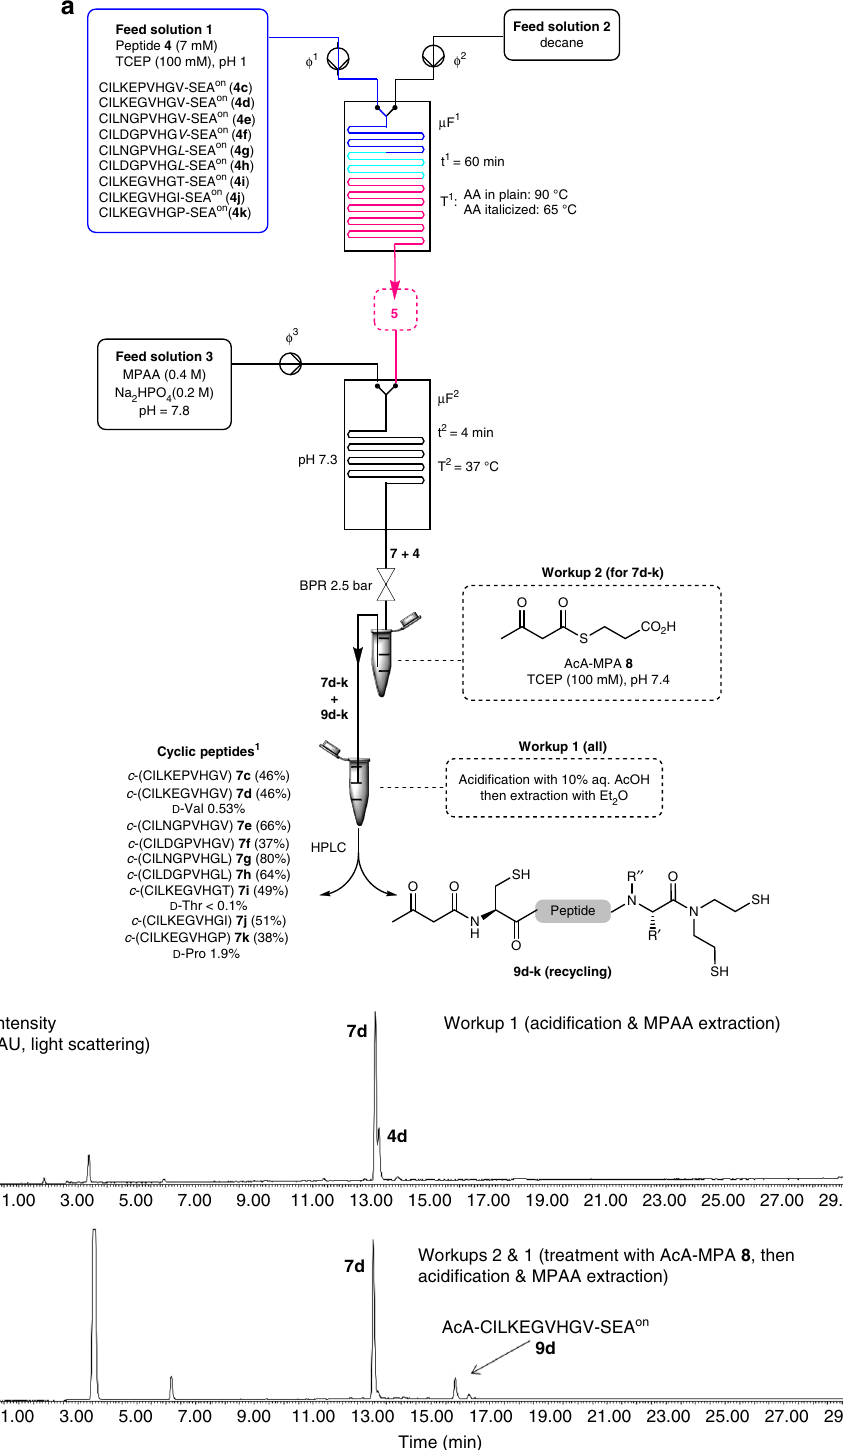
Fig. 4 Optimized micro fl uidic setup. a Details of the optimized micro fl uidic system. The pH of the MPAA feed solution was set at 7.80, leading to an optimum internal pH of 7.3 within micro fl uidic element µ F 2 , and the residence time t 2 to 4 min. ϕ 1 = ϕ 2 = 3.3 µ L min − 1 , ϕ 3 = 35 µ L min − 1 . The back pressure regulator (BPR) was set at 2.5 bars. The peptide concentration in the Feed solution 1 was 7 mM. For 7c , the reactor ef fl uent was quenched in 10% aqueous acetic acid. MPAA was then extracted with diethylether (5×) before HPLC analysis and puri fi cation (workup 1). For 7d-k , the cyclic peptide co-eluted by HPLC with the starting SEA on peptide 4 . Therefore, the reactor ef fl uent was treated fi rst with AcA-MPA 8 /TCEP dissolved in pH 7.4 phosphate buffer (workup 2) and then according to workup 1. 1 Isolated yields after HPLC puri fi cation. R ′ and R ′′ are for side-chain amino acids (see Fig. 1). b Representative HPLC chromatogram for cyclized peptide 7d after workup 1 (top) or workup 2 and 1